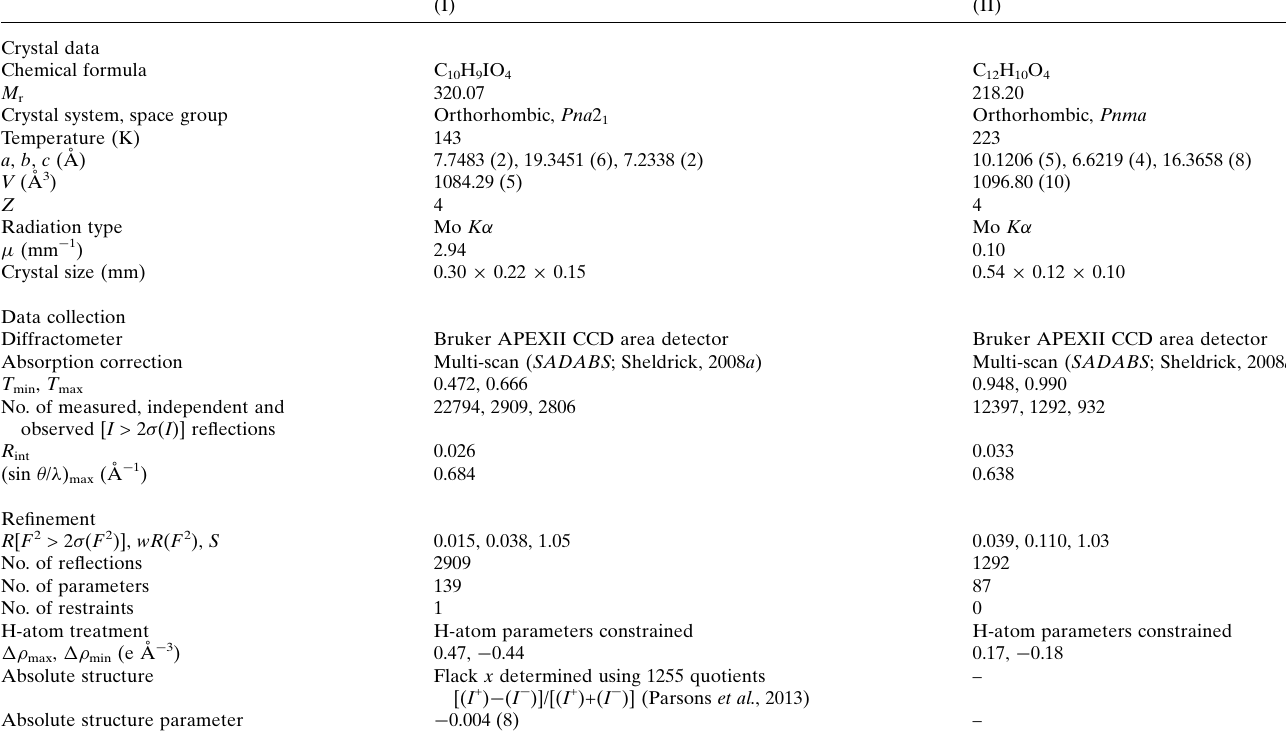
Table 3 Experimental details.